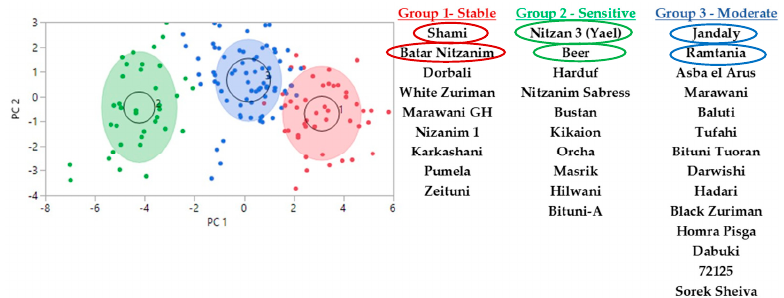
Figure 1. K-means cluster analysis and clustering of the 33 tested varieties into strategic groups. At five time points, the varieties were clustered by their physiological parameters during an extended drought stress experiment. The physiological parameters measured were carbon fixation (photosynthesis) (An), stomata conductance (g s ), and stem water potential. Group 1—stable varieties, showing improved parameters at the late stages of the experiment, marked red. Group 2—sensitive varieties that reacted dramatically to the extended drought period, marked green. Group 3—varieties with a moderate response, marked blue. Each dot represents data for a specific vine, four vines per variety, for a total of 132 vines. Circles are drawn over varieties that were selected for emphasis in the following figures (Figures 2 and 3).